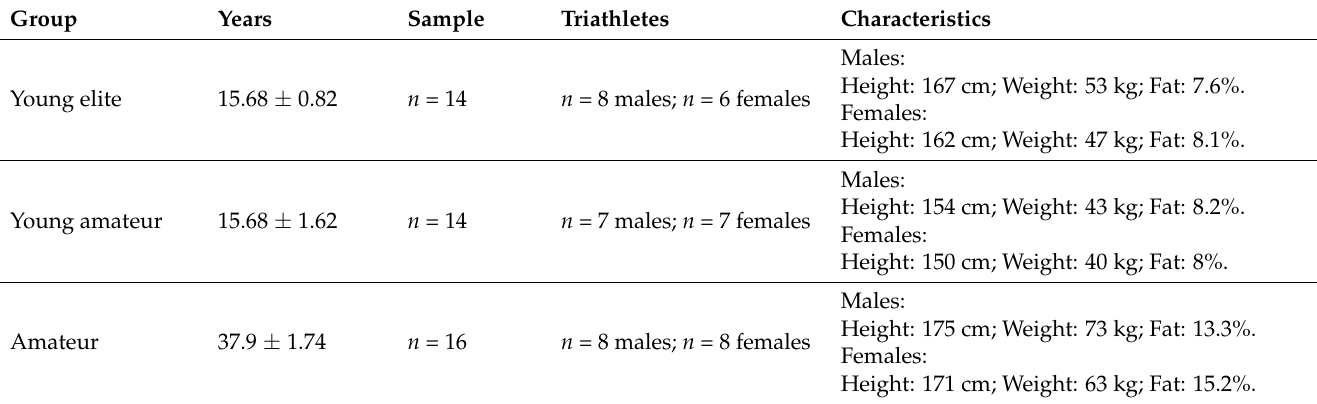
Table 1. Physical and biological characteristics of the selected